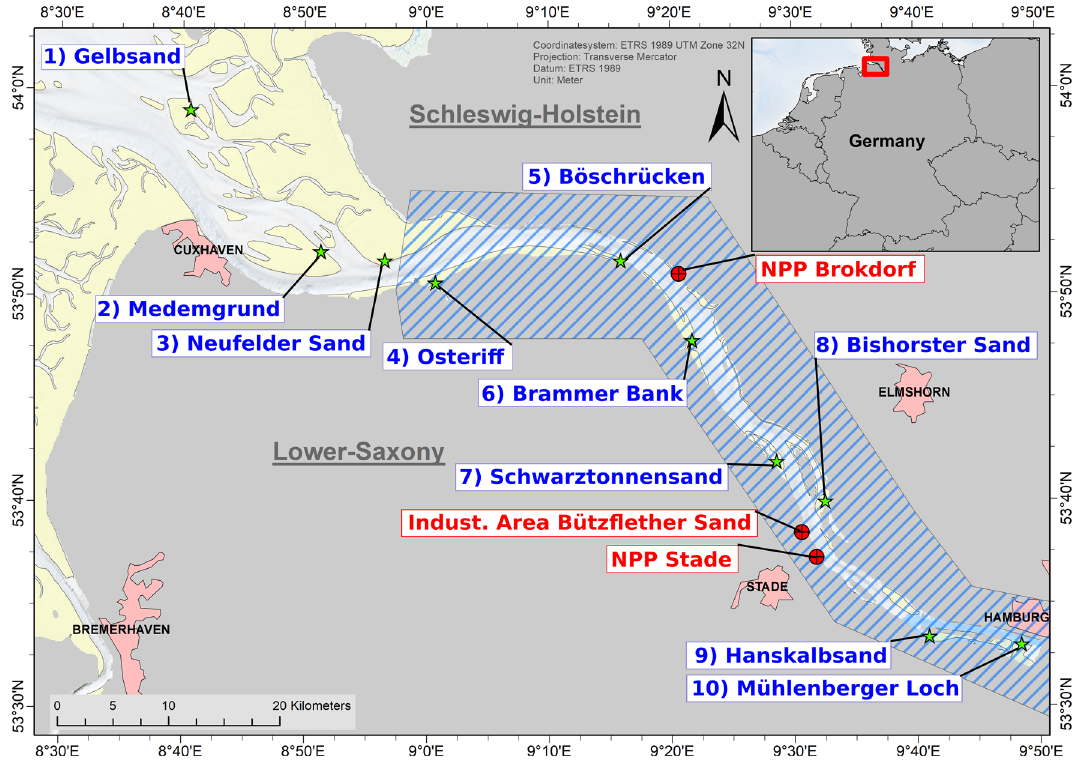
Figure 1. Map of the research area as part of the Elbe estuary. Green stars indicate known haul outs based on the data presented in Taupp 20 which were considered as locations for catching harbour seals. Red markers indicate locations of industrial sites, including the two nuclear power plants (NPP) Brokdorf and Stade. The blue hatched area represents the area considered as inner estuary. The map was created using ArcGIS Vers. 10.6